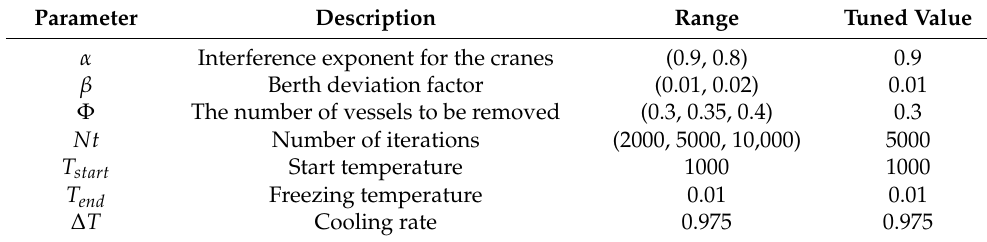
Table 3. Parameters of the LNS algorithm.